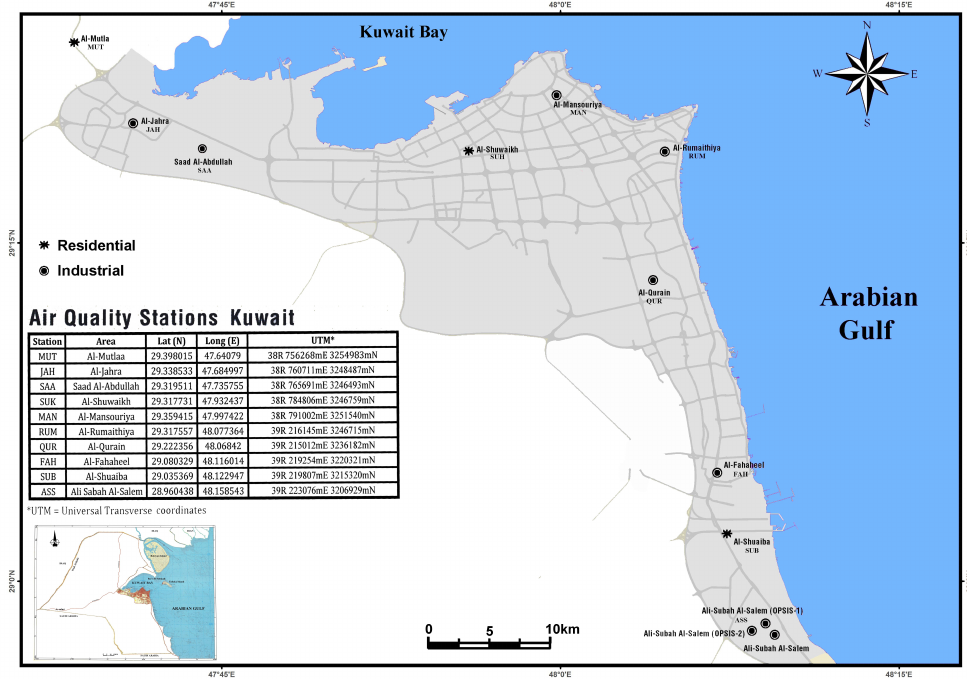
Figure 1. Location map of the selected monitoring stations—modified after K-EPA eMISK